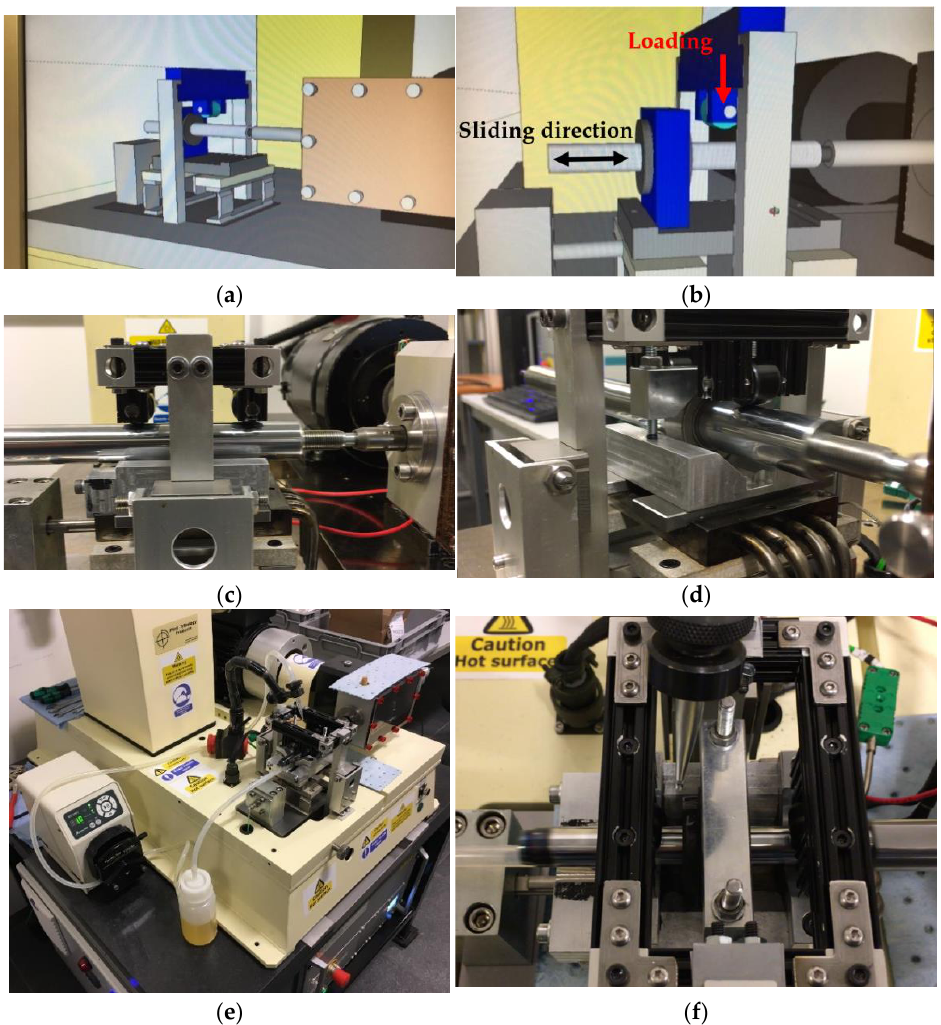
Figure 3. ( a,b ) Schematic for updating TE-77 machine to fit and test actual components. ( c ) Modified holder to fit rod directly onto the driving arm of the TE-77 machine and rollers to apply lateral load. ( d ) Holder to clamp rod guide onto TE-77 heater plate. ( e ) Actual hydraulic cylinders tested on adapted TE-77 machine, under lubricated sliding conditions. ( f ) Drip feeding oil onto the rod. In these tests, two aspects are evaluated: (a) the friction of the system, which is ex- pressed by the coefficient of friction; and (b) the wear on the coated rod, which indicates material loss. To optimize the test conditions, a series of tests was performed under dif- ferent loads and times. From these exploratory tests, it was found that trying to accelerate